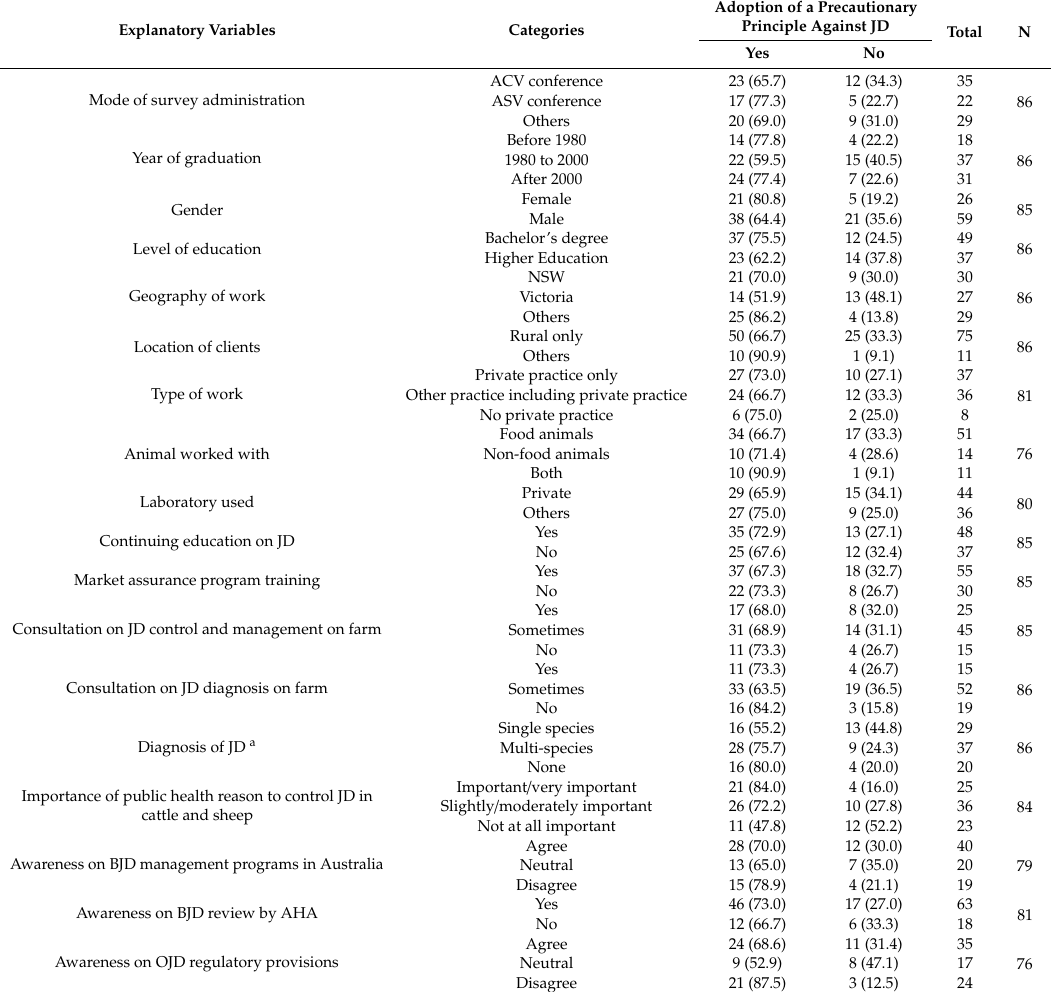
Table 5. Contingency tables of the ‘consideration of veterinarians for adoption of ‘precautionary principle’ against Johne’s disease (JD)’ with assessed explanatory variables based on a study conducted in Australia in